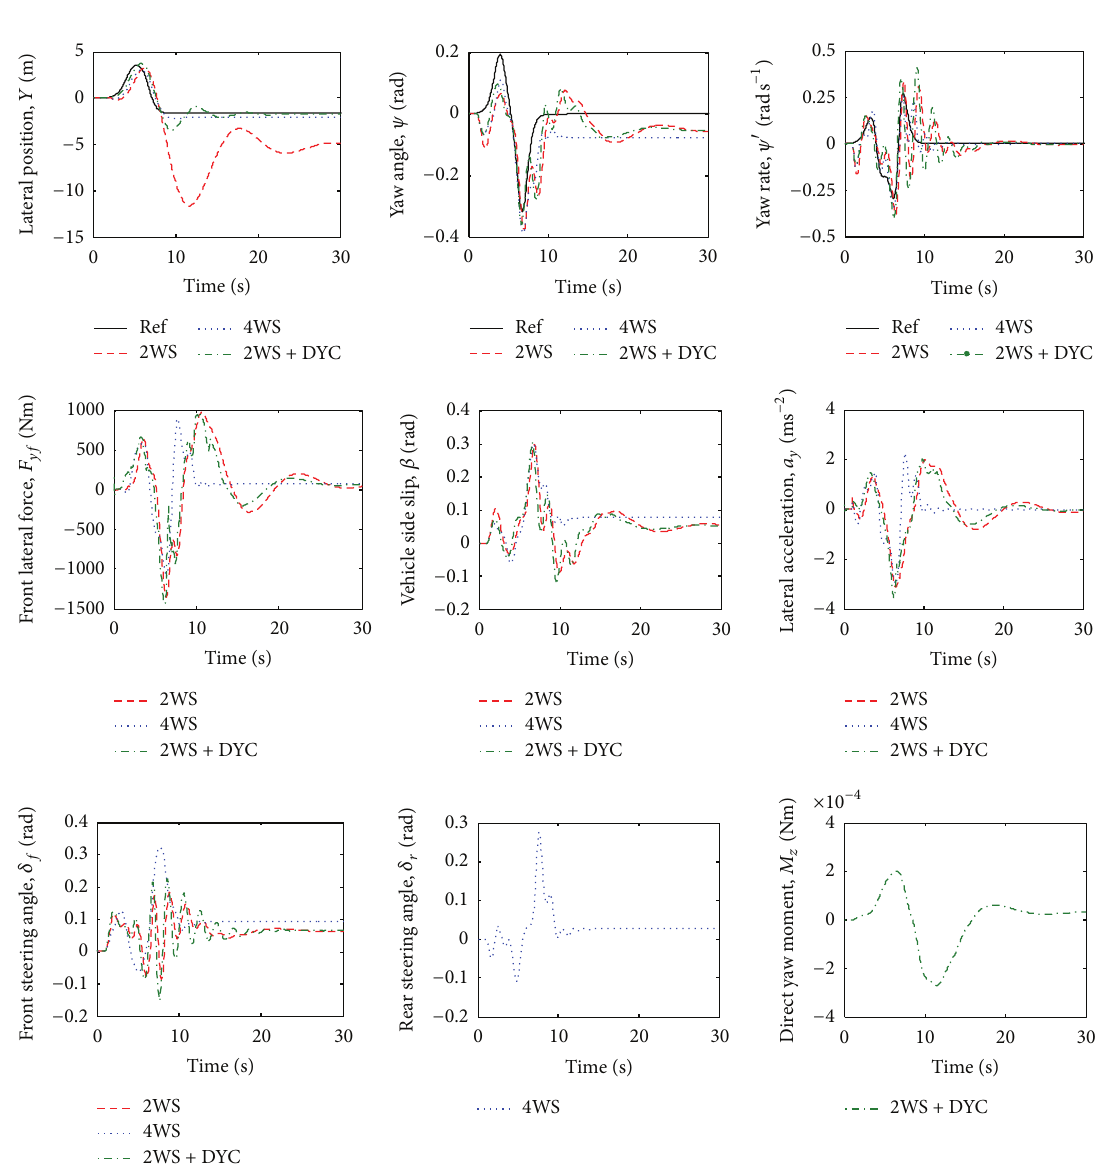
Figure 15: 3DoF controller at 30 ms −1 and 𝜇 = 0.1 by 2WS, 4WS, and 2WS +